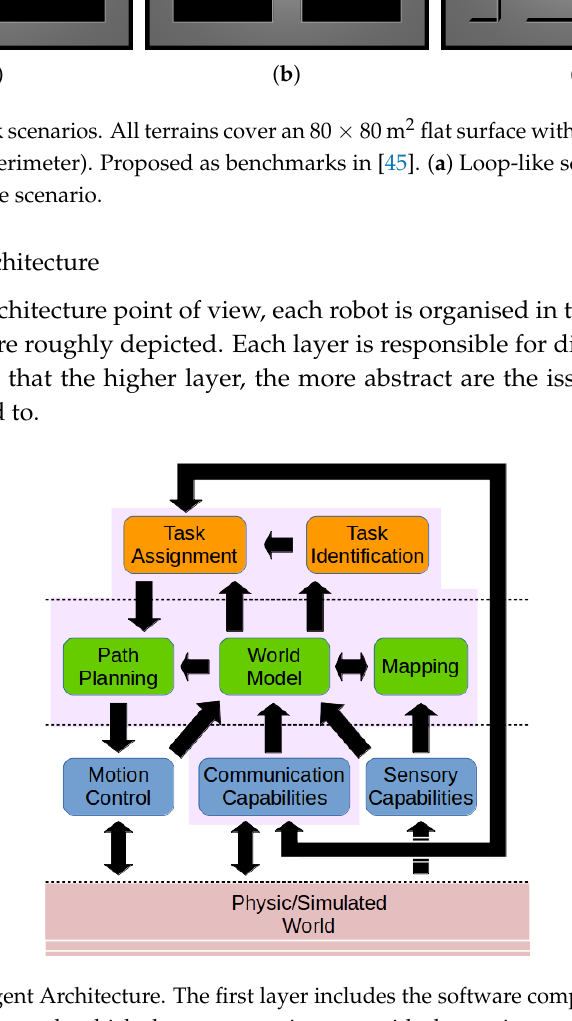
80 m 2 flat surface with static obstacles (walls ×